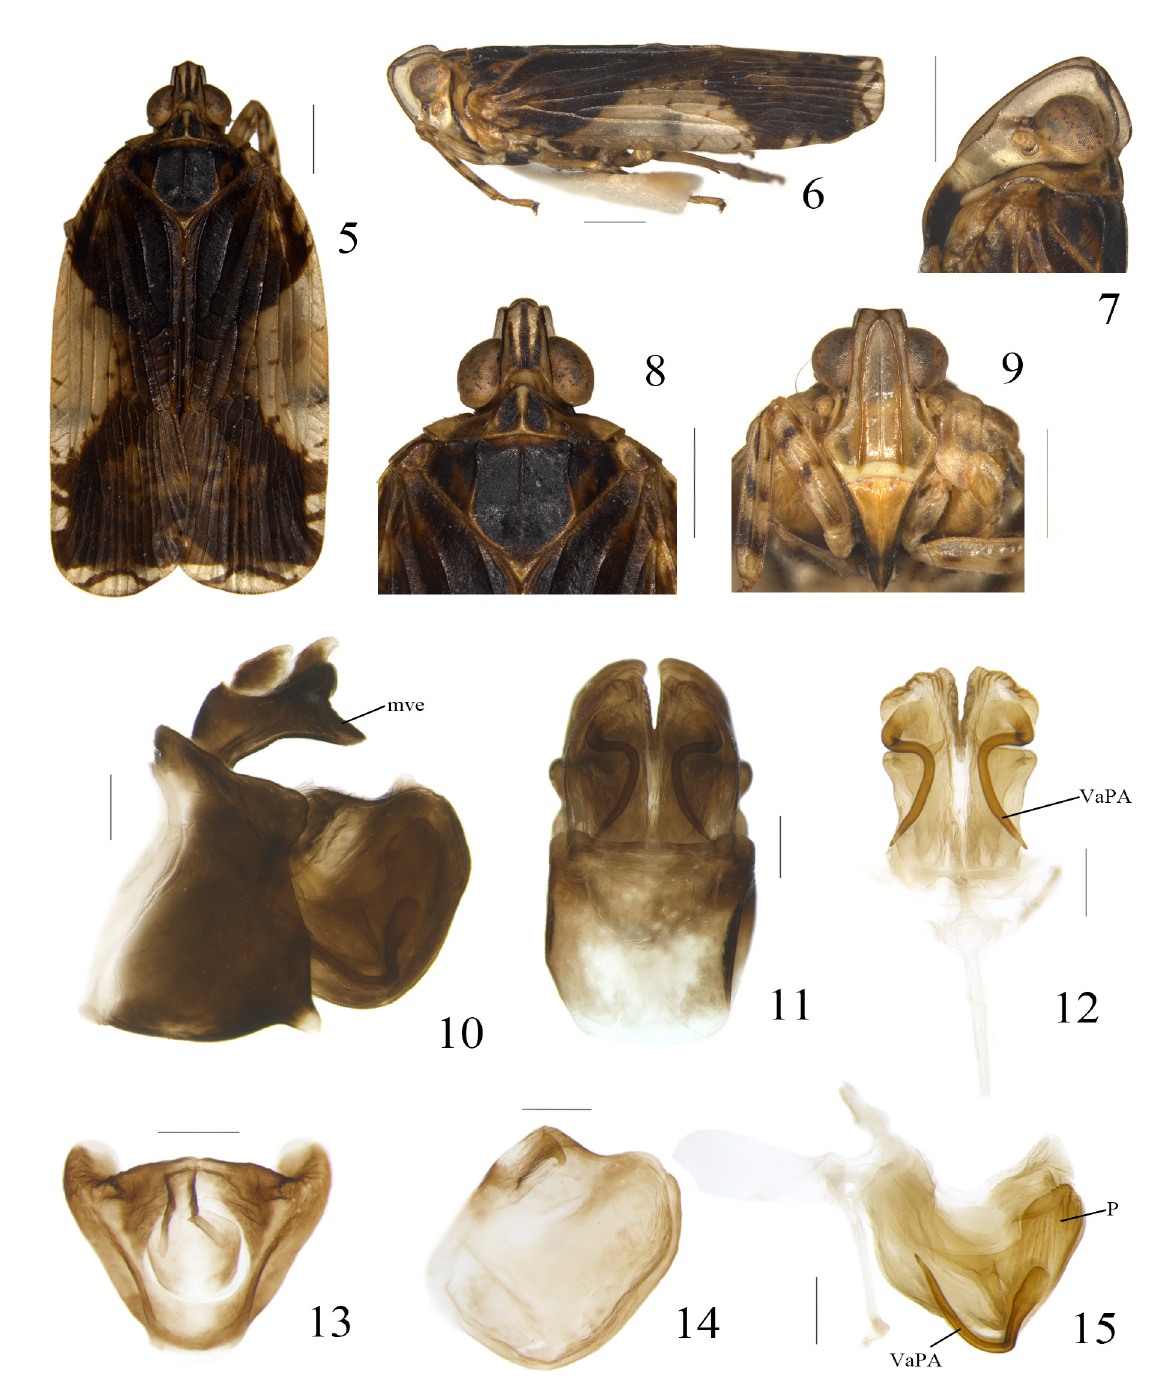
Figs 5–15. Pitambara triremiprocta Wang & Soulier-Perkins, sp. nov., holotype, ♂. 5 . Habitus, dorsal view. 6 . Habitus, lateral view. 7 . Head, lateral view. 8 . Head and thorax, dorsal view. 9 . Frons and clypeus. 10 . Male terminalia, lateral view. 11 . Male terminalia, ventral view. 12 . Phallic complex, ventral view. 13 . Anal tube, dorsal view. 14 . Gonostylus, lateral view. 15 . Phallic complex and tectiform structure, lateral view. Scale bars: 5–9 = 1 mm: 10–15 = 0.2